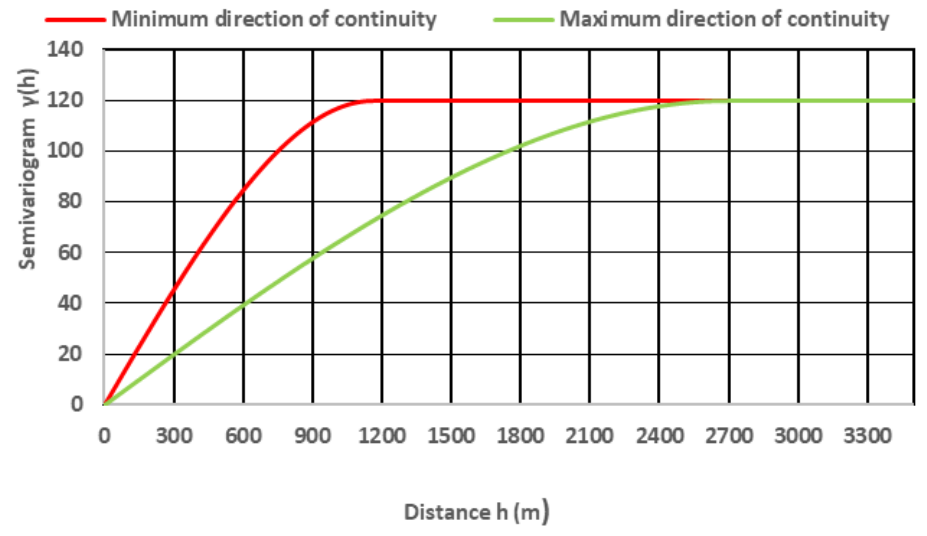
Figure 7: Anisotropic semivariogram model for the liquefaction potential index.